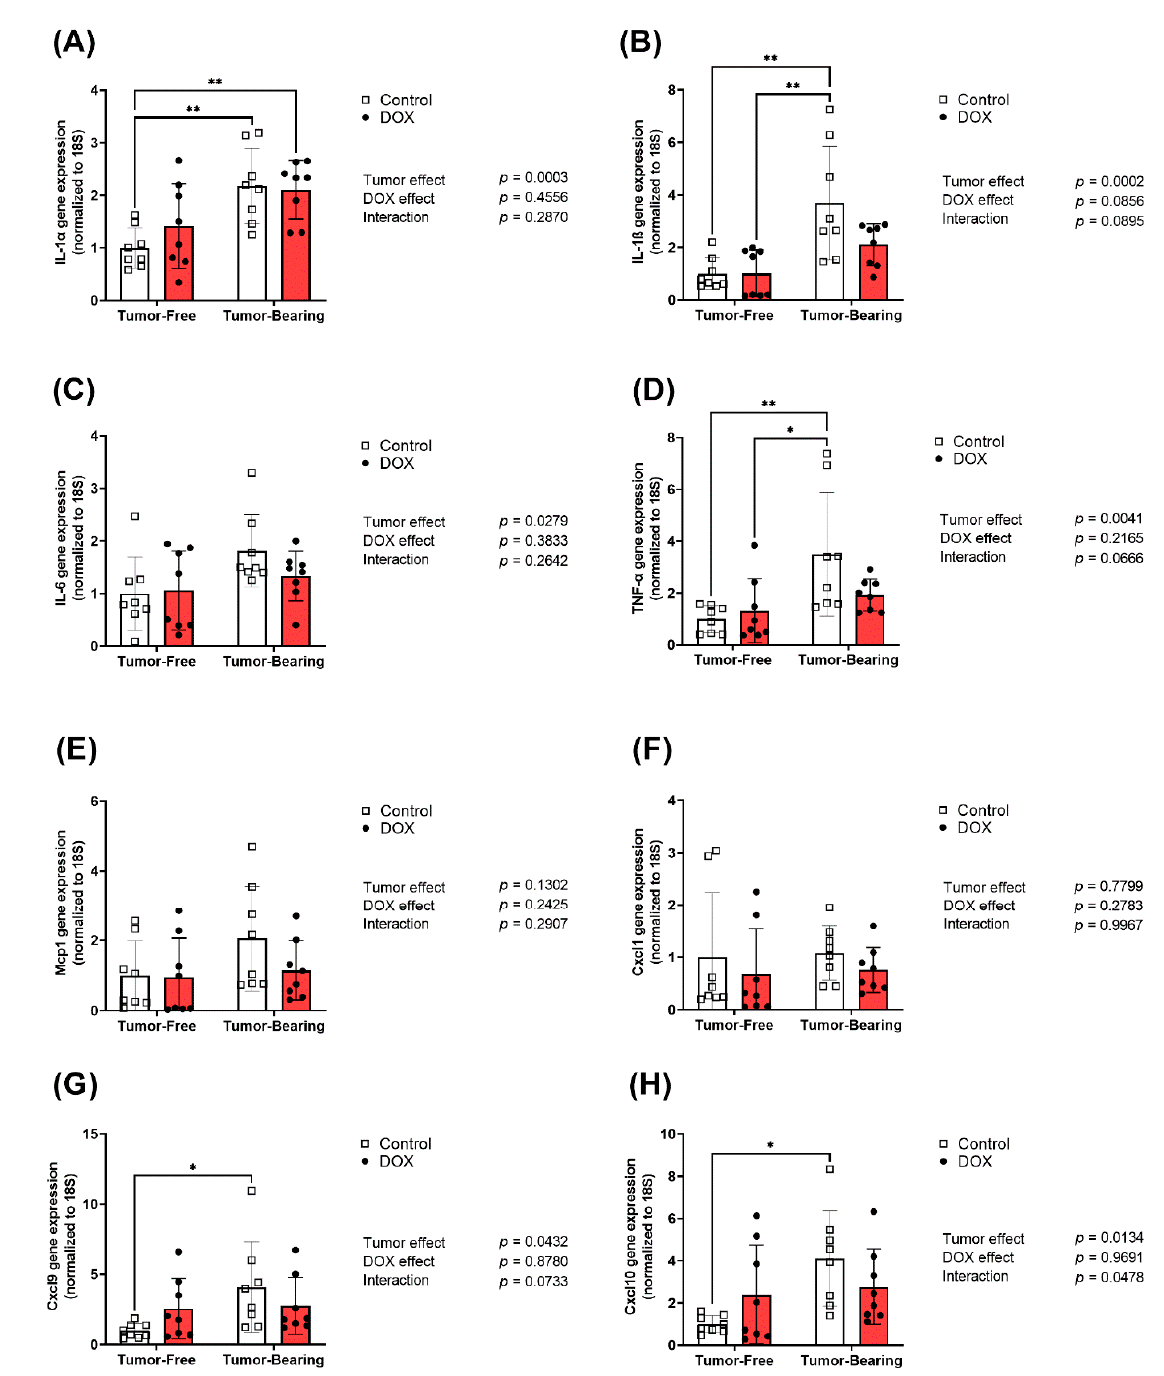
Figure 4. Chronic administration of DOX (4 mg/kg/week) for 3 weeks abrogates tumor-induced upregulation of inflammatory markers in the liver. Livers were harvested from both tumor-free and EL4 lymphoma tumor-bearing juvenile C57BL/6N mice one week following the administration of 4 mg/kg/week of DOX or equivalent volume of sterile saline for 3 weeks ( n = 8 per group). Following the extraction of total RNA, hepatic mRNA expression of ( A ) IL-1 α , ( B ) IL-1 β , ( C ) IL-6, ( D ) TNF- α , ( E ) Mcp-1, ( F ) Cxcl1, ( G ) Cxcl9, and ( H ) Cxcl10 were determined by real-time PCR. Values were normalized to 18S rRNA and expressed relative to saline-treated tumor-free mice. Values are shown as means ± SEM. Two-way ANOVA table demonstrates DOX, tumor, and interaction effects on the mRNA expression. Statistical significance of pairwise comparisons was determined using two-way ANOVA with Tukey’s post hoc analysis (* p < 0.05, ** p < 0.01).